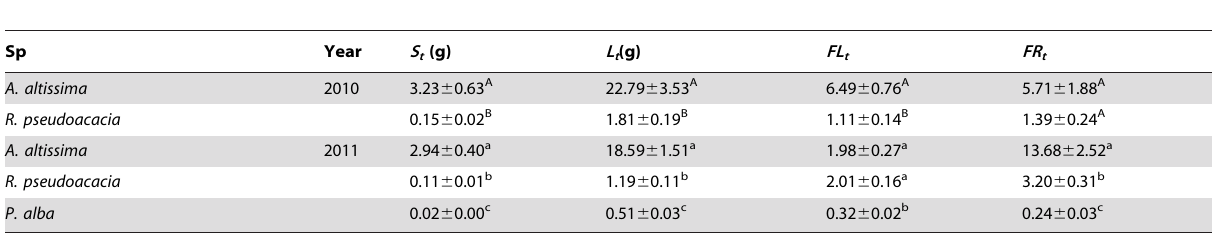
Table 2. Gross branch production per species, year and organ